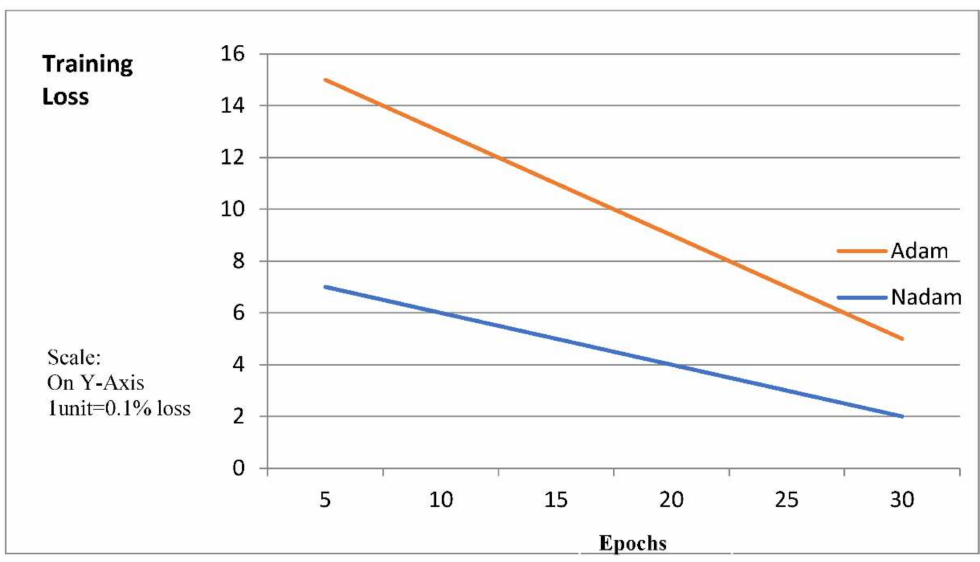
Figure 15. Comparison between different optimizers.